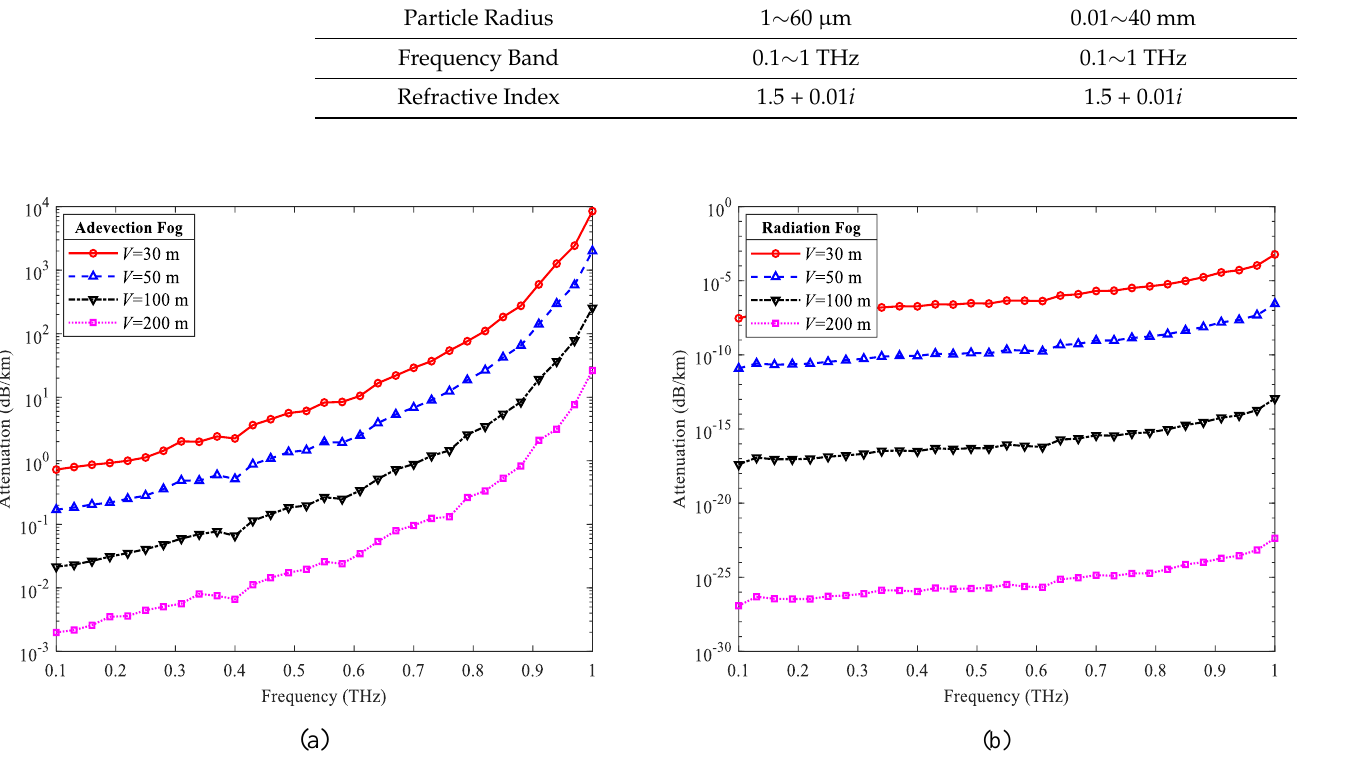
Figure 5. ( a ) Advection fog attenuation under various visibilities; ( b ) radiation fog attenuation under various